Question: What visual encoding does this figure use to show its data?
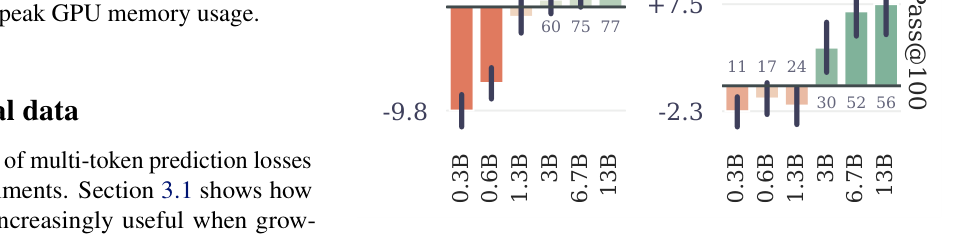
Answer: bar